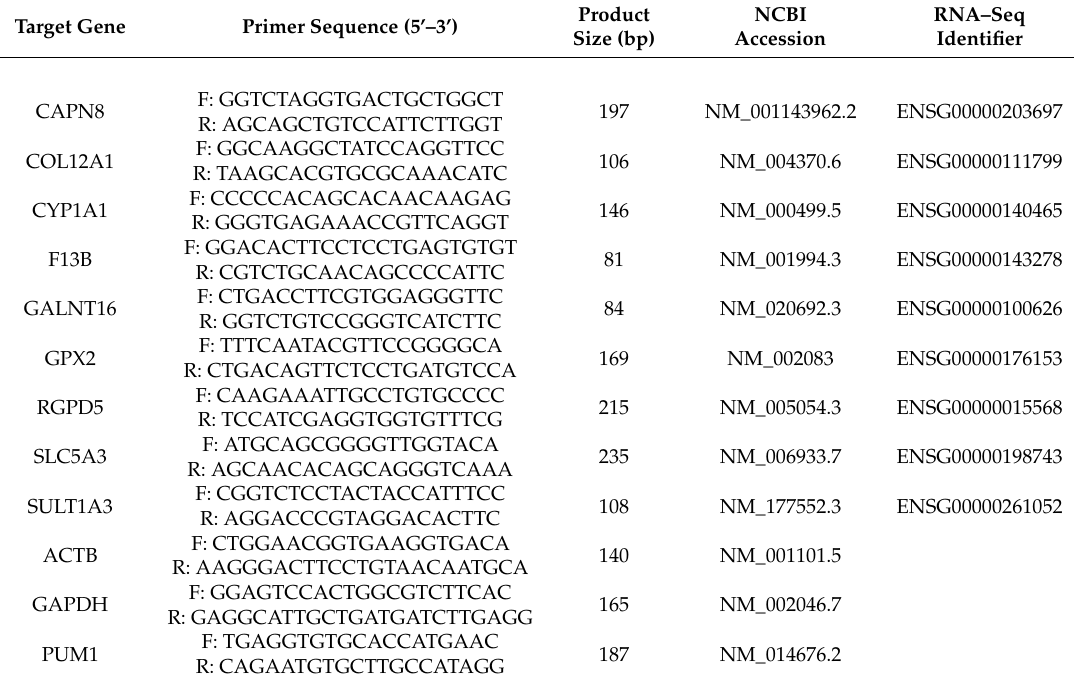
Table 3. Primer sequences for RNA-seq validation by